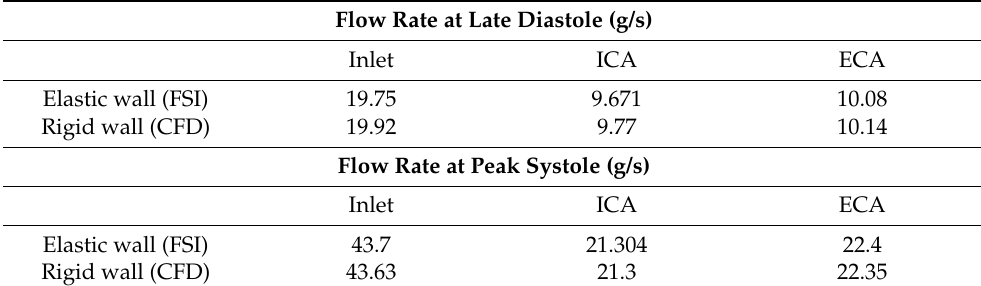
Table 5. Stenotic ICA (model B) mass flow rate distribution at the late diastole and peak systole of the cardiac cycle for elastic and rigid